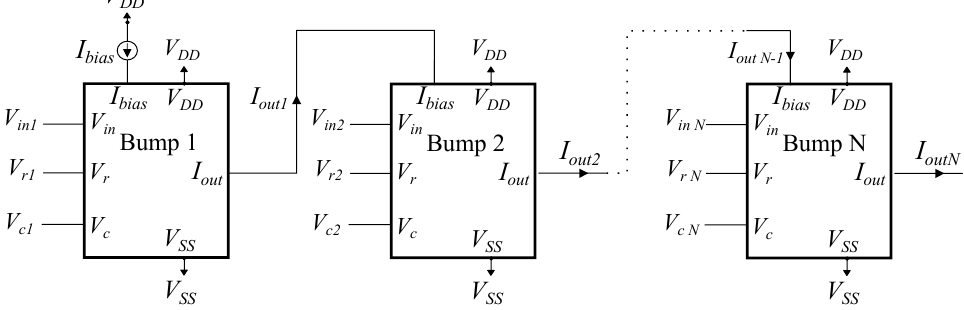
Figure 4. By connecting N simple bump circuits sequentially, the output of the last one is equivalent to an N –D Gaussian function. Each bump circuit’s parameters ( V r , V c , I bias ) are tuned